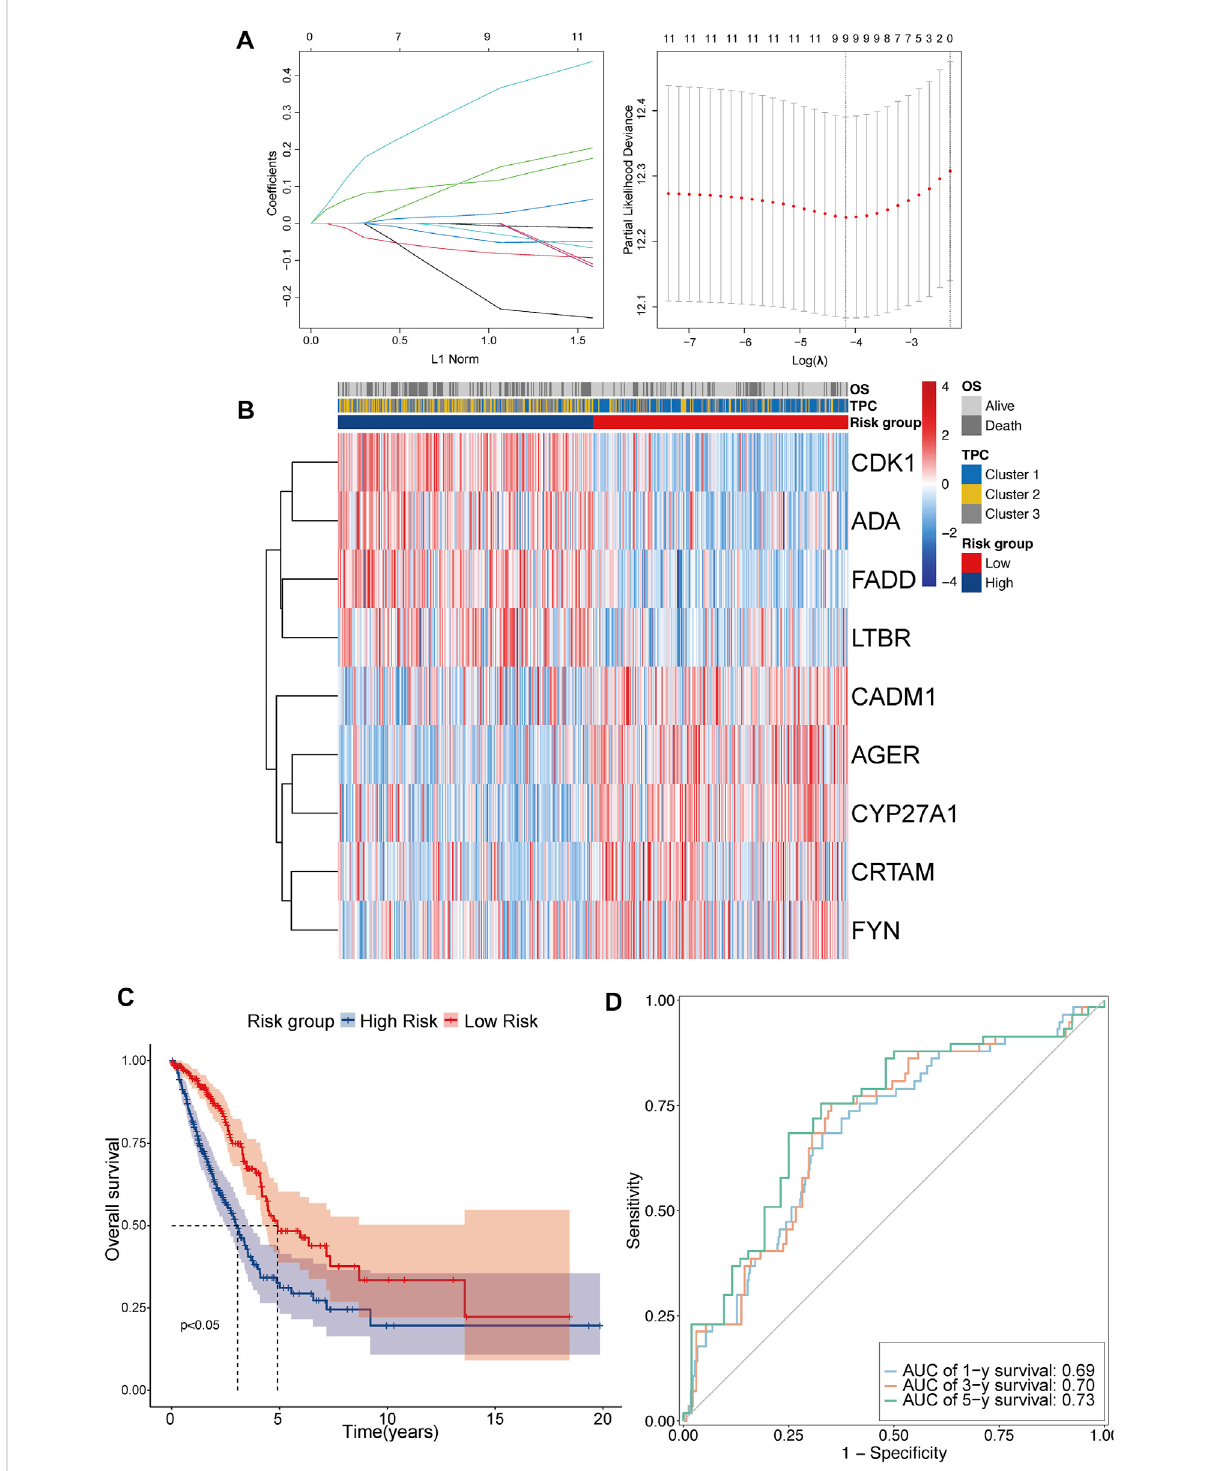
FIGURE 5 Construct the TPR-related risk model in TCGA-LUAD. (A,B) Lasso-Cox regression model analysis results and heatmap of T cell proliferation prognostic model signature: (A) lasso regression analysis (left panel); partial likelihood deviance for the lasso regression (right panel); dotted line: lambda.min(left)andlambda.se (right); (B) heatmapbetween highandlow-risk scoresandclinicalparameters. (C) KMcurvesshowingOS inpatients with risk group; blue line: high-risk score ( n = 250) and red line: low-risk score ( n = 250). (D) Receiver operating characteristic (ROC) curve of 1 (light blue), 3 (orange), and 5 years